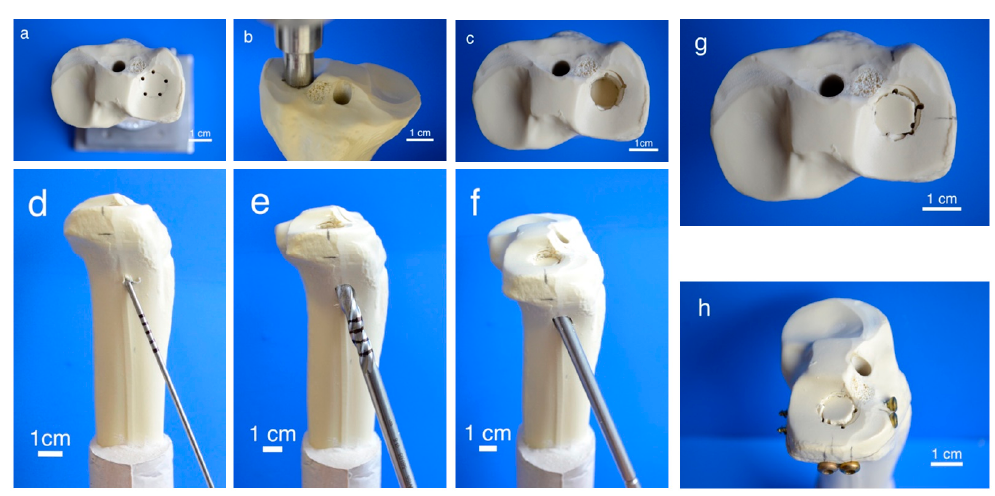
Table 2. Experimental groups; display of the seven groups for biomechanical analysis of tibial head fractures using osteosynthesis techniques and storage conditions.